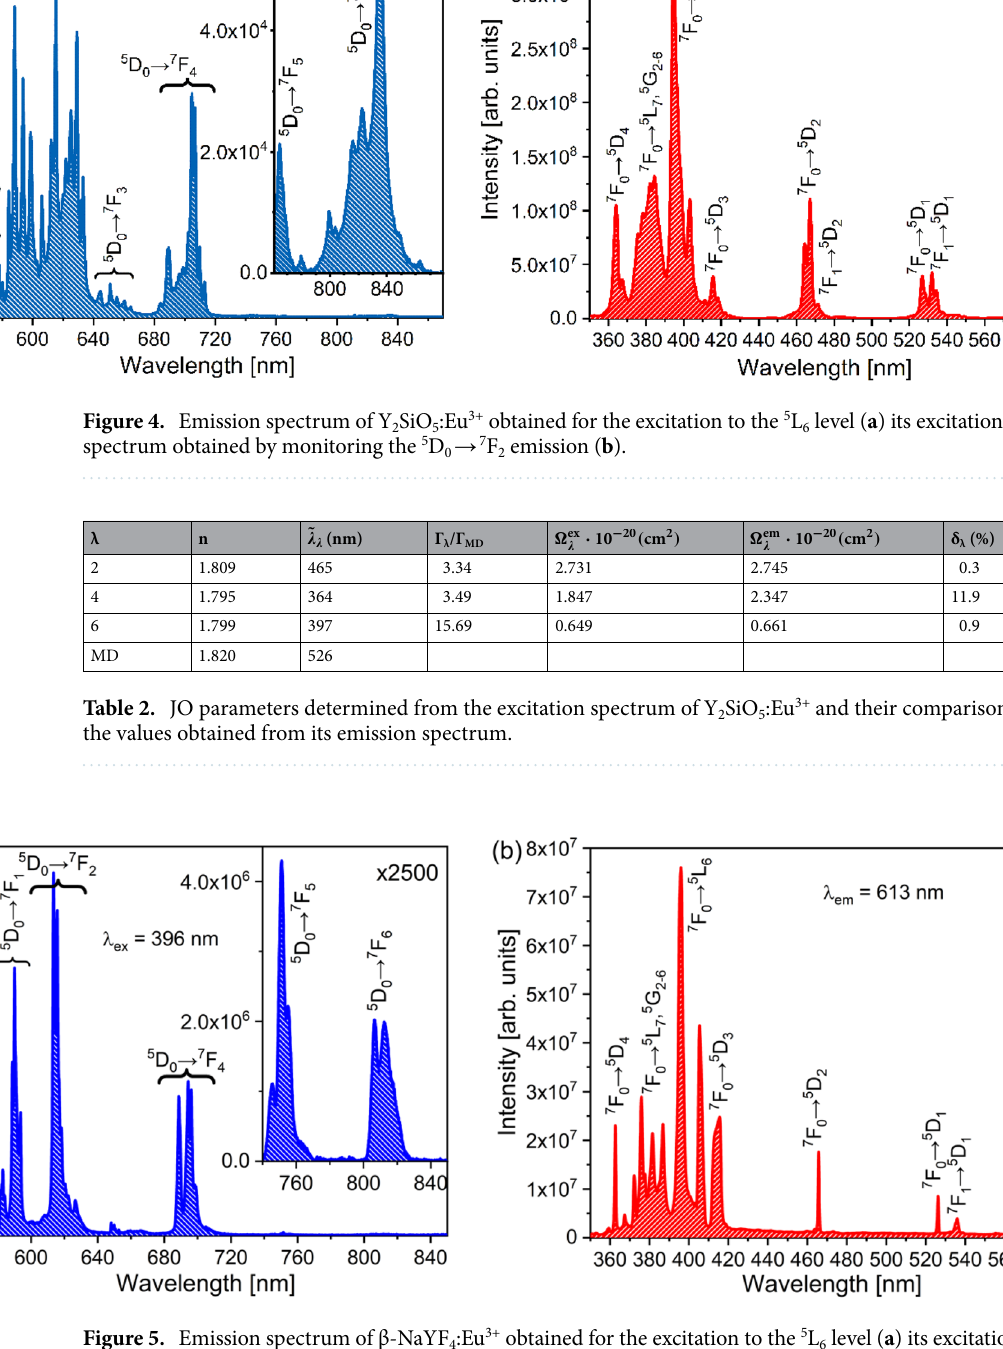
Figure 5. Emission spectrum of β-NaYF 4 :Eu 3+ obtained for the excitation to the 5 L 6 level ( a ) its excitation spectrum obtained by monitoring the 5 D 0 → 7 F 2 emission ( b ).